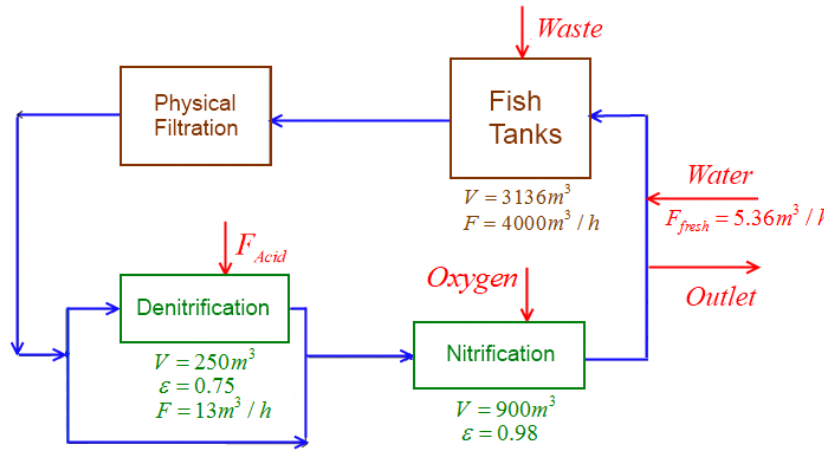
Figure 1. industrial scale RAS.